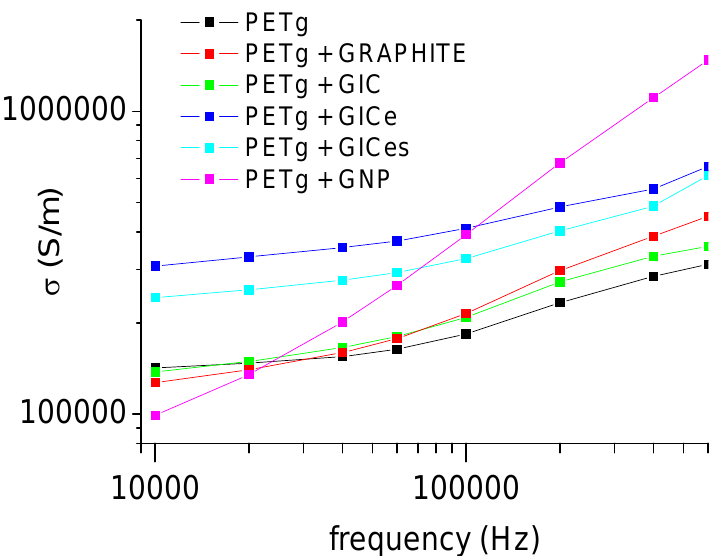
Figure 9. Electric conductivity of PETg nanocomposites.